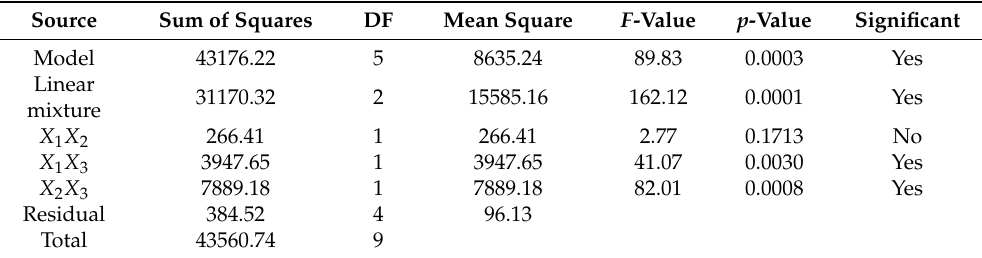
Table 11. ANOVA results for coefficient of viscosity Burgers model ( η 1 ).